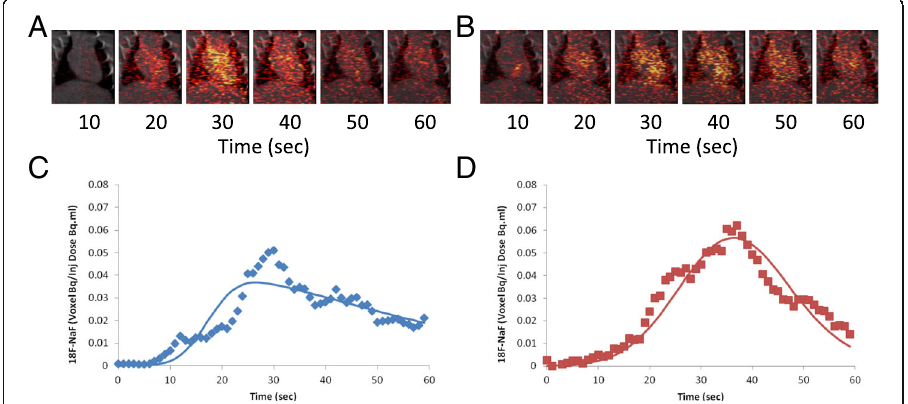
Fig. 3 Fused 18 F-NaF PET/CT view-sharing reconstructed images with time of the heart prior to ( a ) and post ( b )-xylazine infusion at 13.8 mg/kg min, where the corresponding kinetic time courses pre ( c ) and post ( d ) are shown below each image series, where solid line represent the fit of the described model. Reconstructions utilized a 9-s frame duration with a 1 s offset as described in Fig.